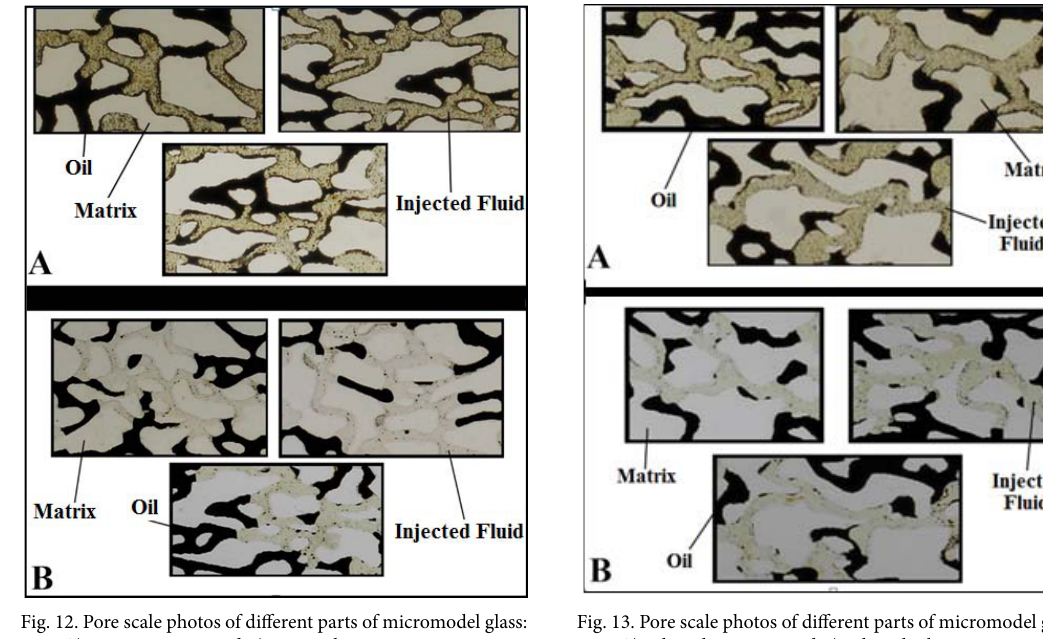
Fig. 12. Pore scale photos of different parts of micromodel glass: A) water injection and B) water-silica injection